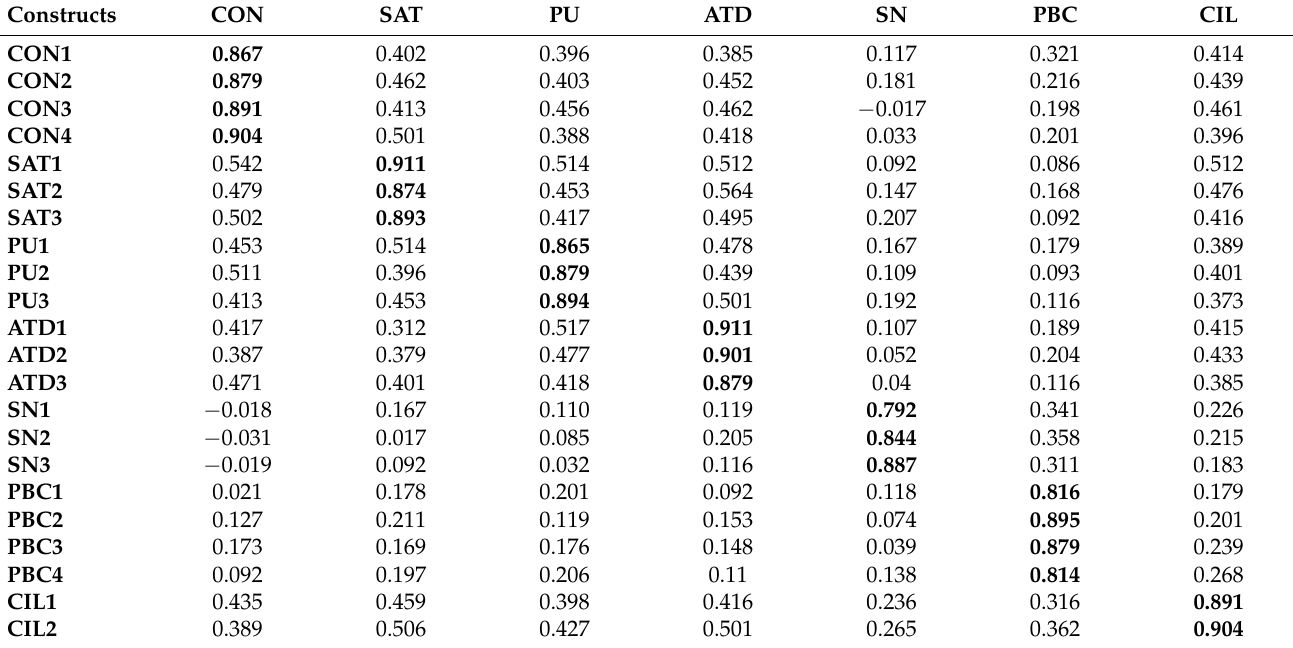
Table 5. Cross-loading criterion.